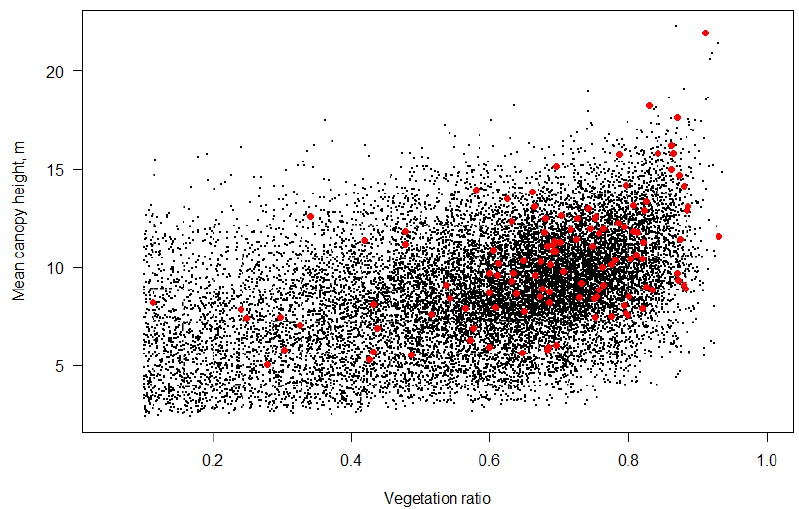
Figure 1. Variation in forest density (Vegetation ratio) and height (Mean canopy height) in the Evo study area. Black dots represent all possible field plots and the red dots describe the 120 field sample plots that were selected.